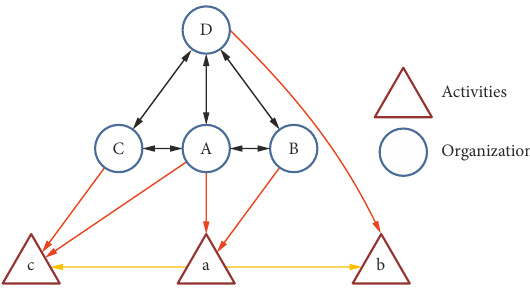
Figure 2. Cascade effect of organization-innovation activities